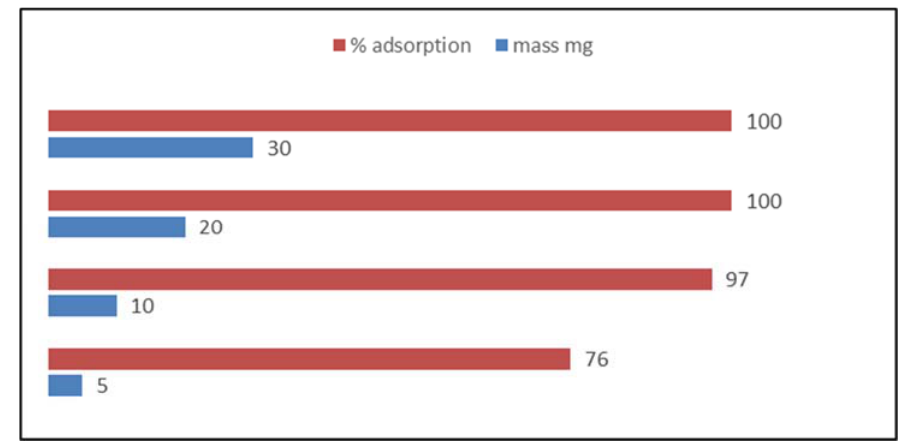
Figure 2. Mass effect on Cu 2+ adsorption onto CMK ‐ 3 (at 25 °C, pH 6 and [Cu 2+ ] = 30 ppm).